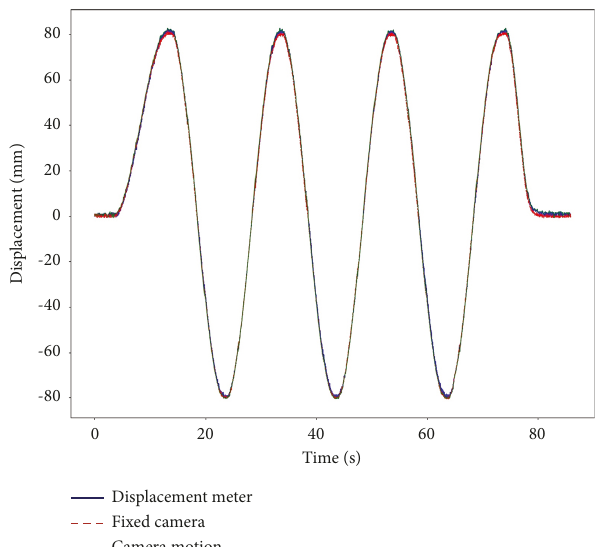
Figure 8: Displacement time history of 100% shear deformation of isolated bearing achieved using various displacement measurement methods.